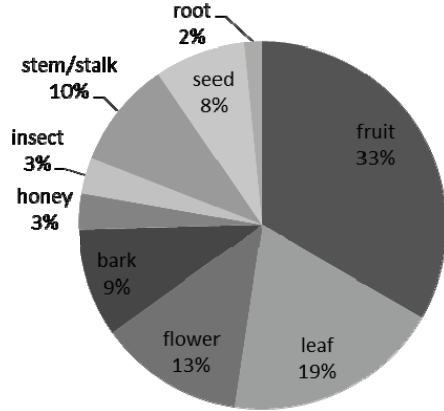
Figure 3. Percentage of food parts consumed (n = 63) during bush-outings during the four-month study